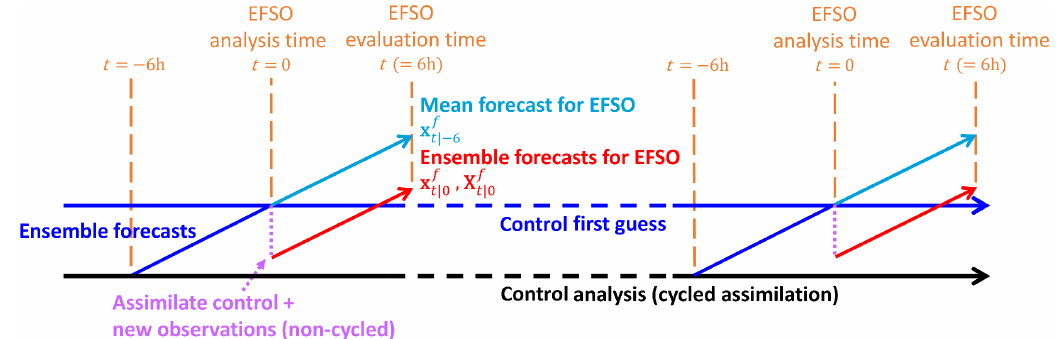
Figure 1. Flowchart of the offline non-cycled EFSO